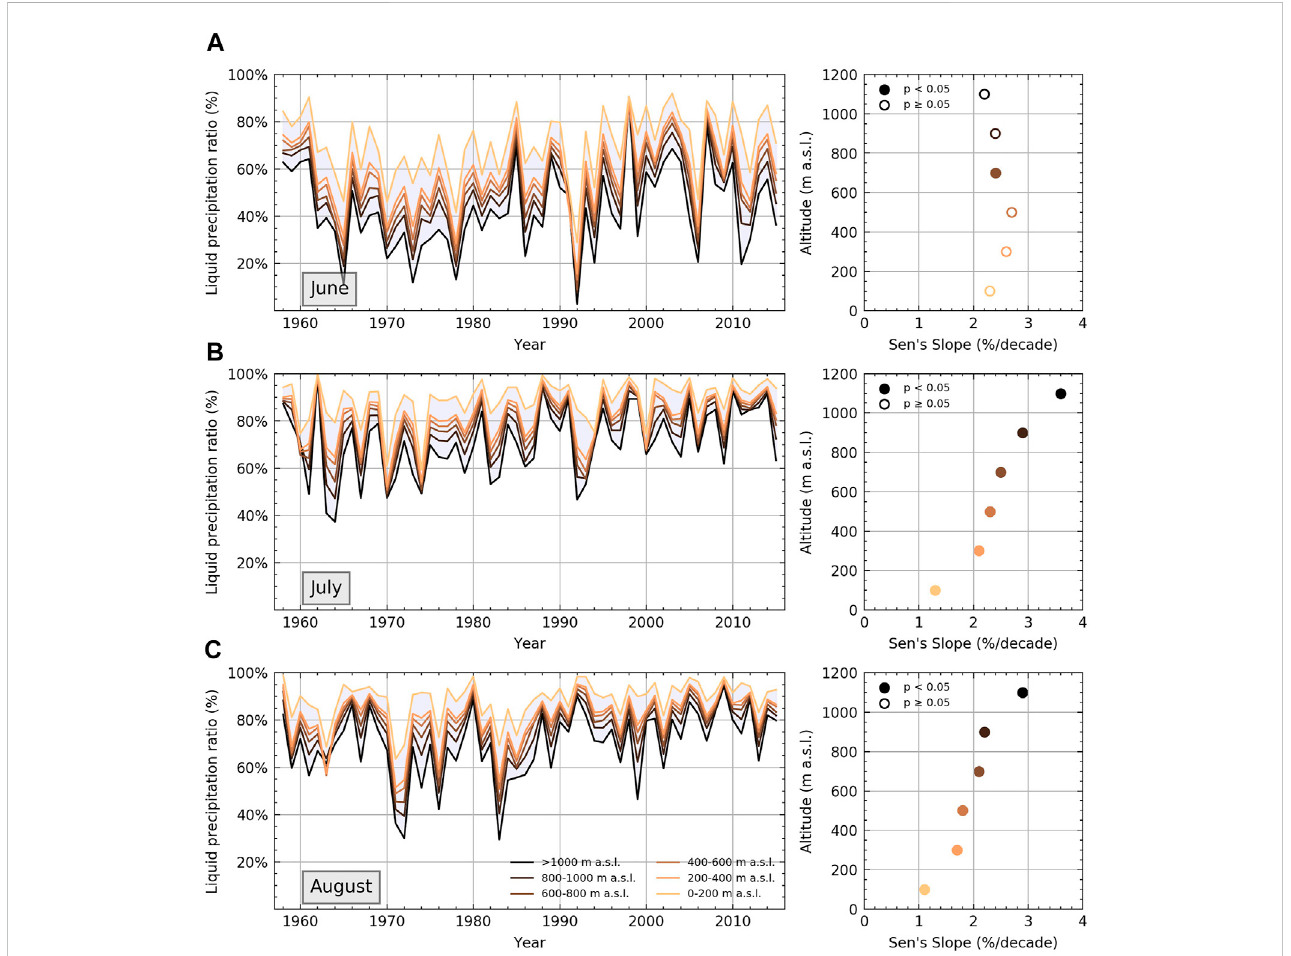
FIGURE 5 RACMO2-1.0 km trends in liquid precipitation ratio at different elevation bands for June (A) , July (B) and August (C) . Sen ’ s slope values at different elevation bands are highlighted in the scatterplots.